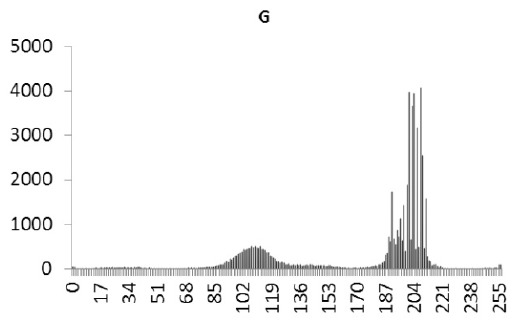
Figure 18. Statistical chart of G value distribution of the original image.